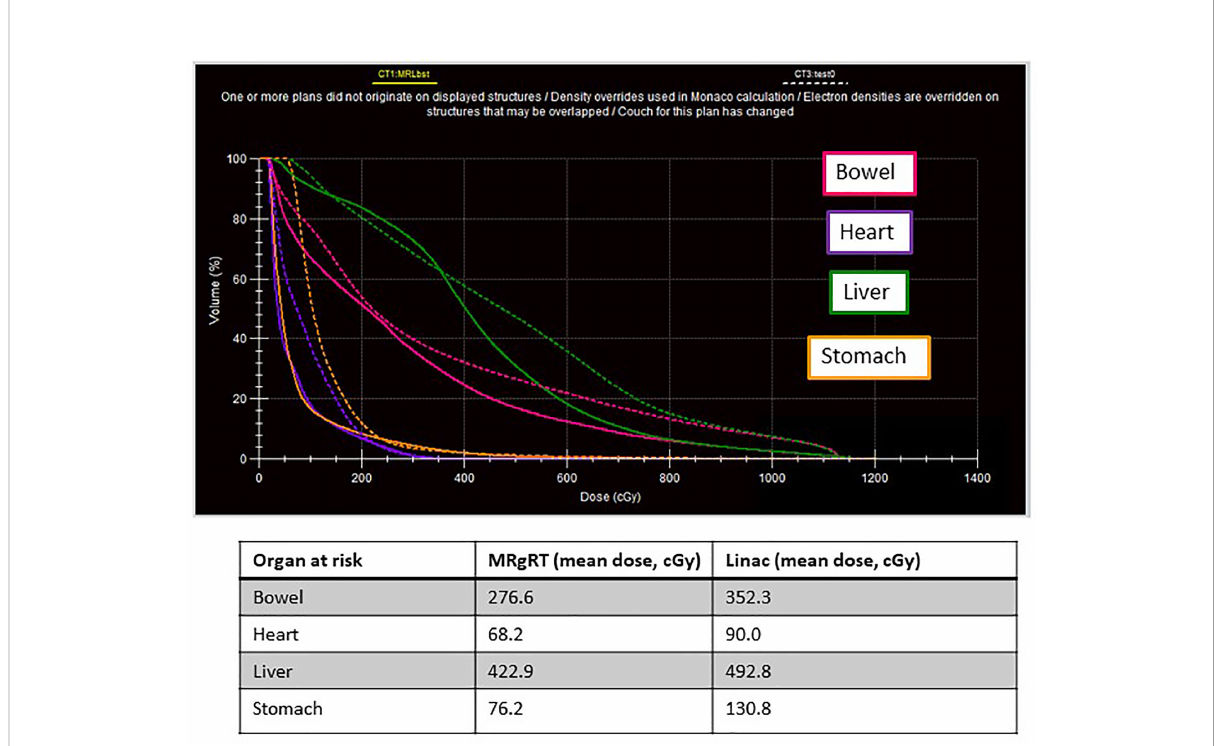
FIGURE 1 A 14-month-old female with favorable histology Wilms tumor and an unresectable IVC tumor thrombus underwent adjuvant fl ank radiation to 10.8 Gy followed by a boost to residual disease to 19.8 Gy. This fi gure represents the dose volume histogram comparing the MRL plan (solid line) with the conventional linac plan (dashed line). Organs at risk are labeled with corresponding